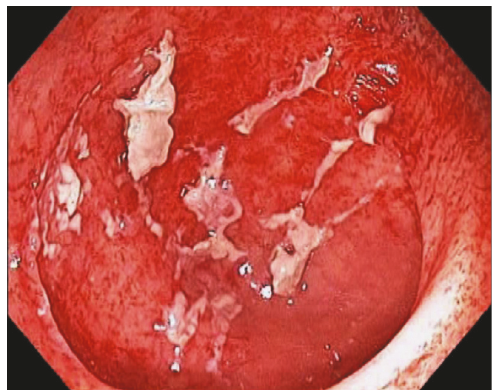
Figure 30: Endoscopic image of diversion colitis involving the cecum showing mucosal edema, erythema, friability, erosions, exudates, and